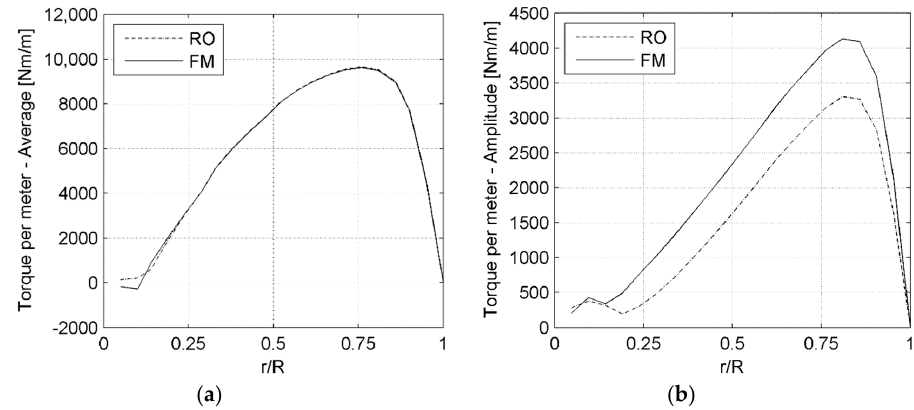
Figure 7. Torque per meter of blade as a function of the span: ( a ) average value and ( b ) peak-to-peak amplitude of the oscillation.